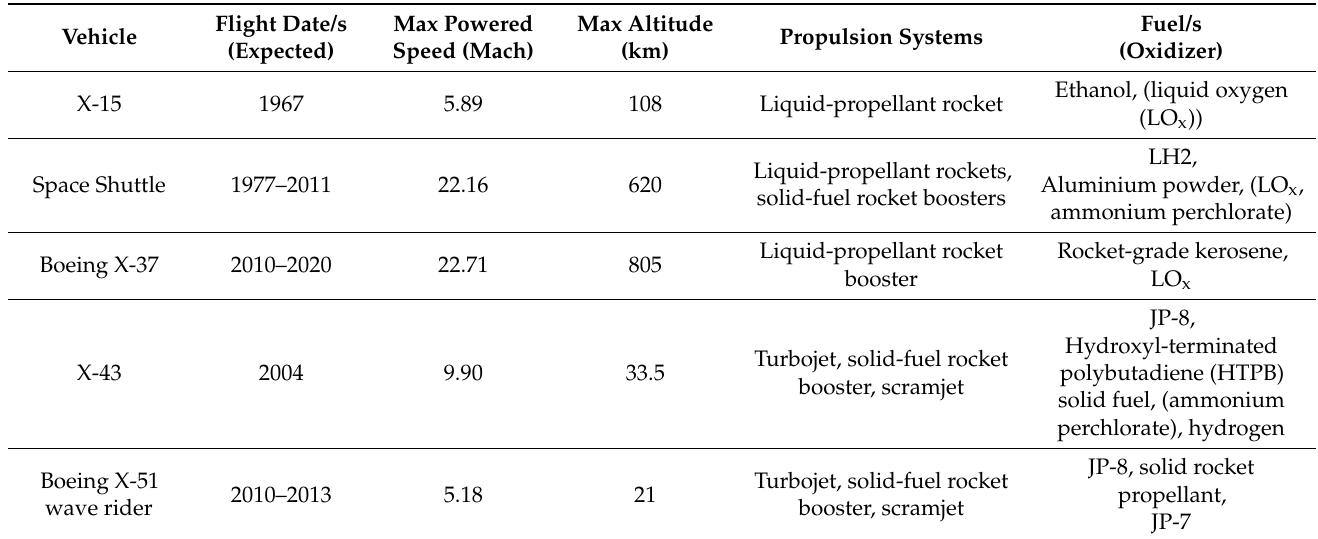
Table 1. Details of Hypersonic Vehicles